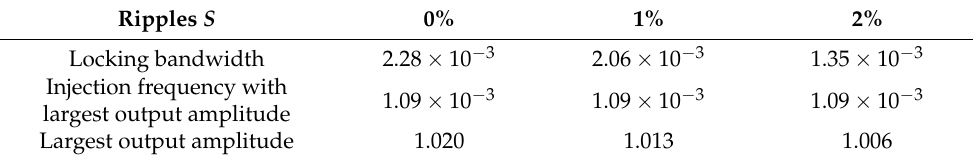
Table 4. Comparison of injection locking in different injection